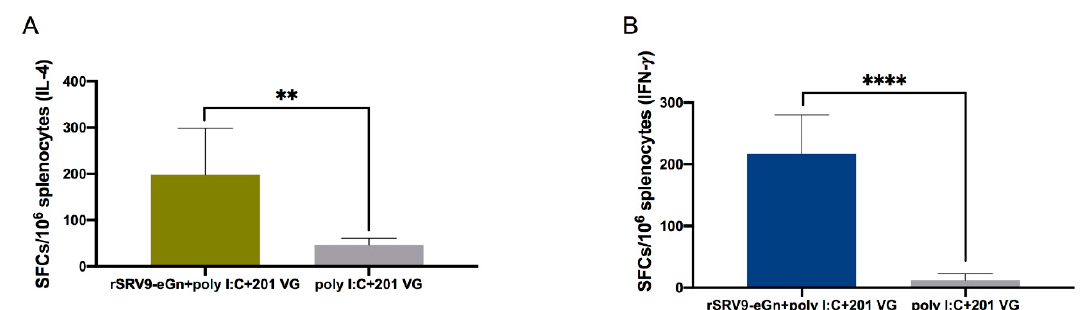
Figure 9. IFN- γ and IL-4 secretion by proliferating splenic T cells induced by a purified RVFV eGn protein. Splenocytes from immunized mice were stimulated with a purified RVFV eGn protein for 36 h, and the levels of IL-4 ( A ) and IFN- γ ( B ) were quantified by ELISpot kits. Data are shown as the mean ± SD and were analysed by an unpaired Student`s test (* P < 0.05, ** P < 0.01, and *** P < 0.001).